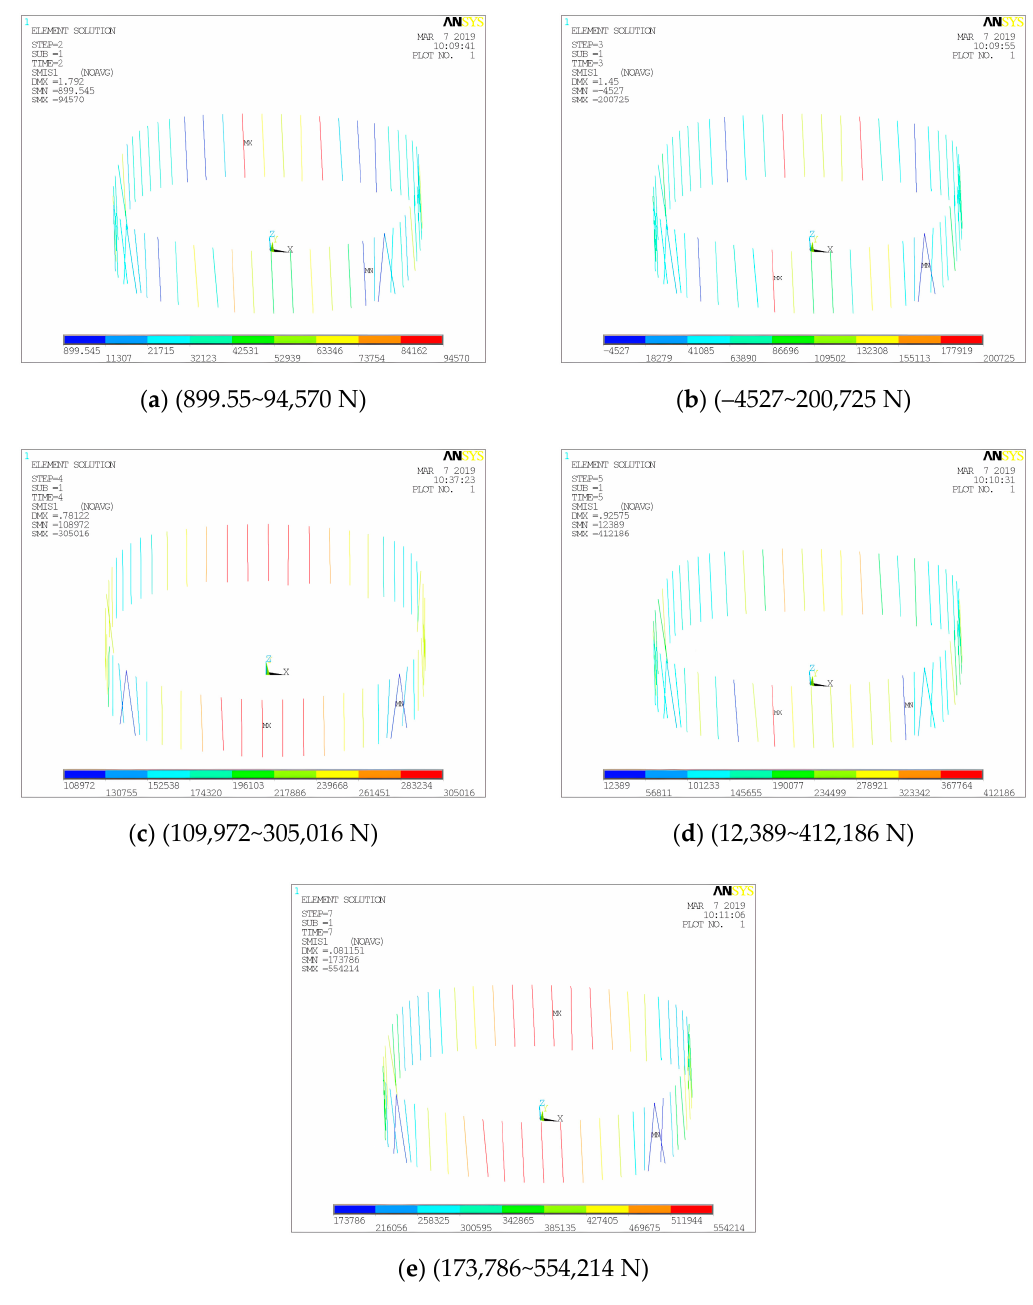
Figure 42. Tie-down force nephograms (N): ( a ) C2, ( b ) C3 ( c ) C4, ( d ) C5, ( e ) C6. Comparisons and Effects The envelope diagram of CR radial deformation before and after adjusting (Figure 43) shows that when the adjusted tie-down tension strategy is adopted, the maximum radial outward expansion deformation of CR can be reduced from 144 to 108